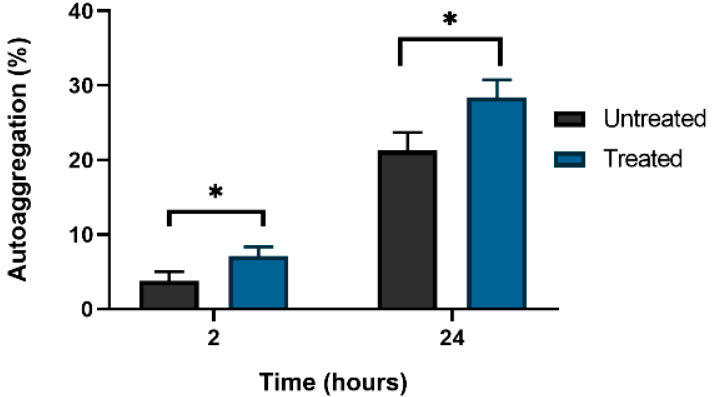
Figure 4. Percentage of C. jejuni auto-aggregation following ex-c-di-GMP treatment. Data are presented as mean ± standard errors (3 or more biological repeats). The asterisk (*) indicates a statistically significant difference compared to the untreated control ( p < 0.05).